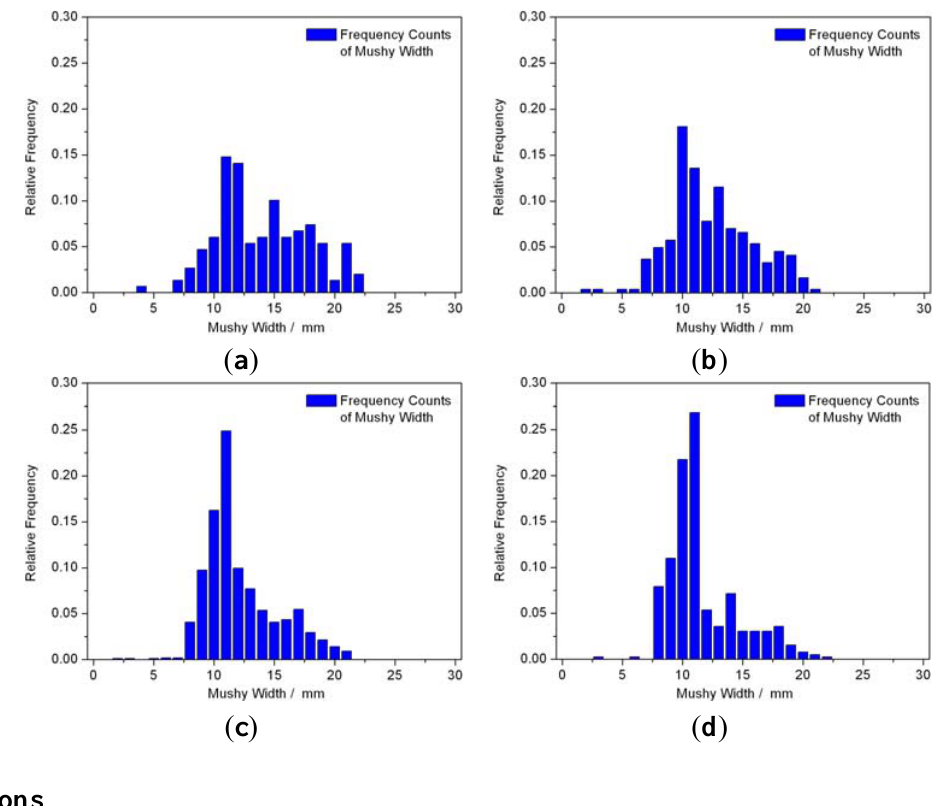
Figure 13. The frequency distributions of mushy zone width of the four simulation